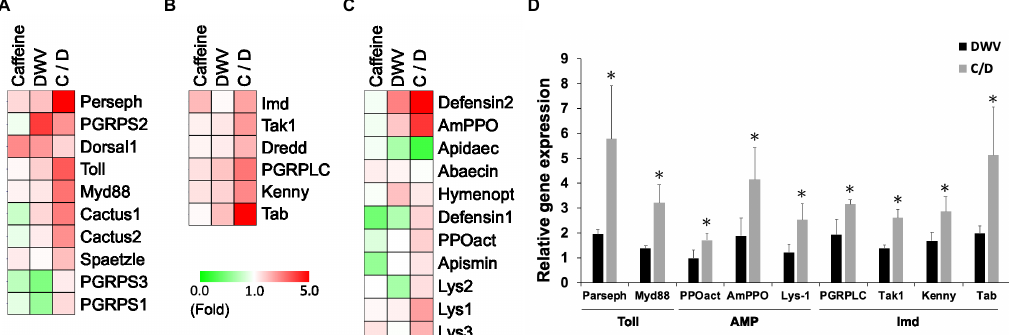
Figure 1. Ca ff eine up-regulates the expression of most genes involved in immune responses upon deformed wing virus (DWV) infection compared to control group. The relative expression rate of immune-related genes involved in ( A ) Toll pathway, ( B ) Imd pathway, and ( C ) anti-microbial peptides (AMPs). C: ca ff eine; DWV: deformed wing virus treatment group; C / D: ca ff eine treatment followed by DWV infection. The results were from real-time polymerase chain reaction (RT-PCR). Clustering analysis was based on the Euclidean distance. ( D ) Relative expression of immune-related genes with significant changes ( p < 0.05). The values from the control groups (without any treatment or infection) were set to 1 and the values of individual genes from treatment groups were normalized accordingly. The results are from data collected from three independent experiments and presented as mean ± standard deviation (SD), n = 3. Statistical analysis was performed using one-way analysis of variance (ANOVA) test followed by Tukey’s post hoc test. * p < 0.05 as compared to the DWV infection only